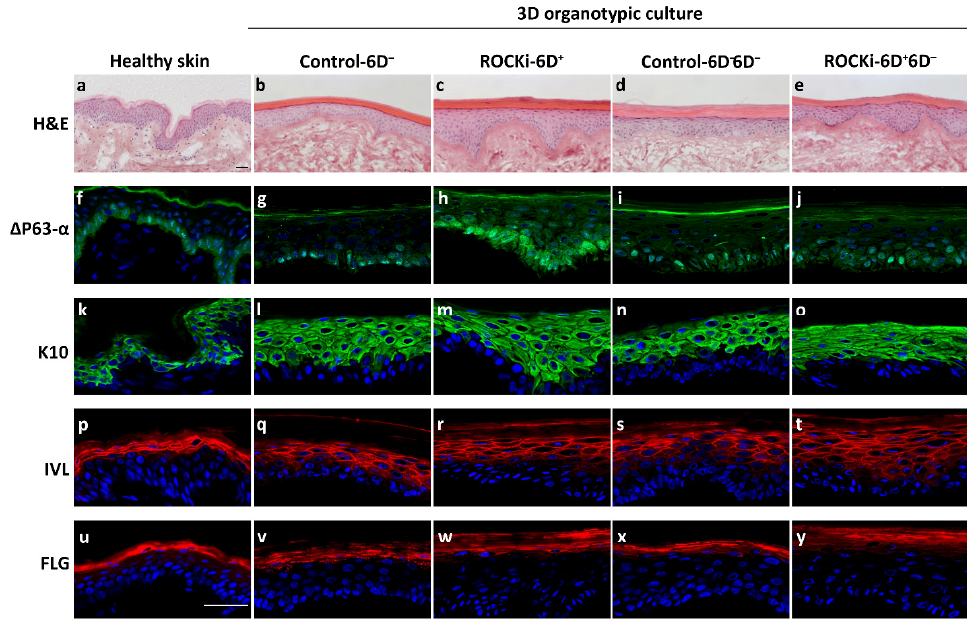
Figure 4. Cells treated with ROCKi for six days had proliferation and differentiation abilities similar to non-treated cells. Three-dimensional organotypic cultures were generated using cells with ROCKi treatment (ROCKi-6D + ), without ROCKi treatment (Control-6D − and Control-6D − 6D − ), and after withdrawing ROCKi treatment (ROCKi-6D + 6D − ). The 3D culture morphology examined by Haematoxylin and eosin (H&E) staining ( a – e ). Proliferation marker ∆ P63- α and differentiation markers K10, involucrin (IVL), and filaggrin (FLG) were examined by immunofluorescence staining ( f – y ). Increased ∆ P63- α expression was detected in ROCKi-6D + compared to other groups of cells, but it was returned to the level to non-treated cells after withdrawal of ROCKi treatment. Nuclei were stained by DAPI (blue). Scale bar = 40 μ m. The expression of these proteins in the skin are shown in ( f , k , p , u ).